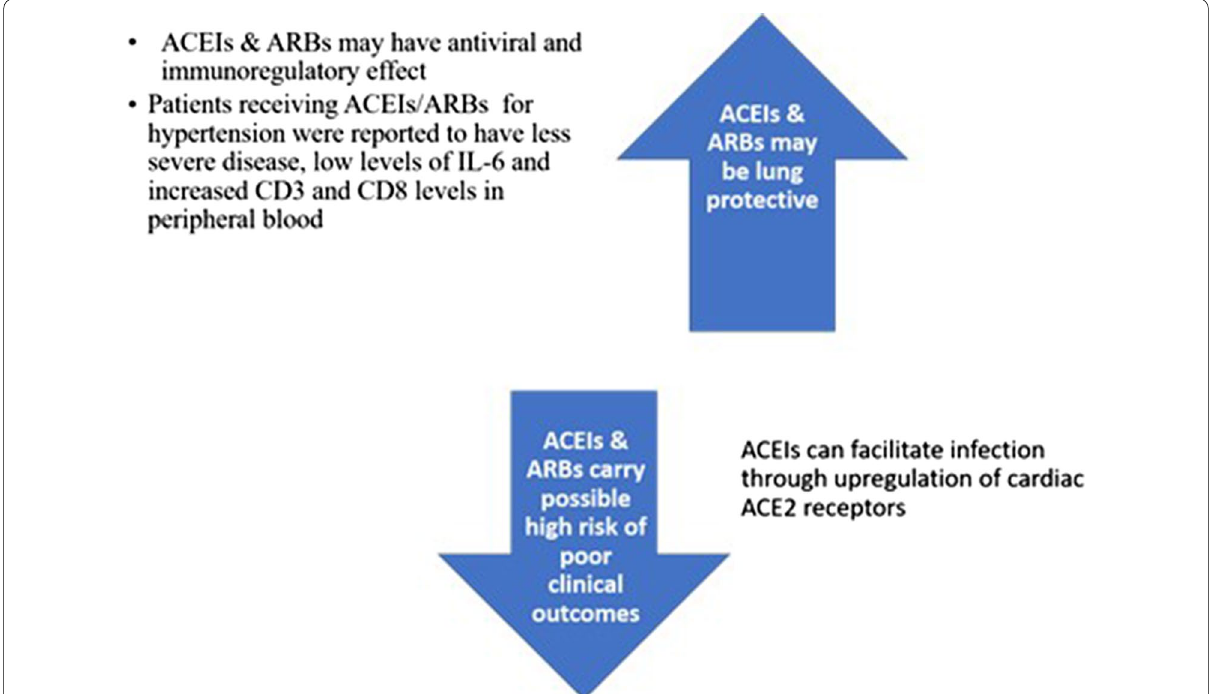
Fig. 3 Controverse about the role of ACEIs & ARBs in COVID-19: There is controverse about the use of ACEIs & ARBs in